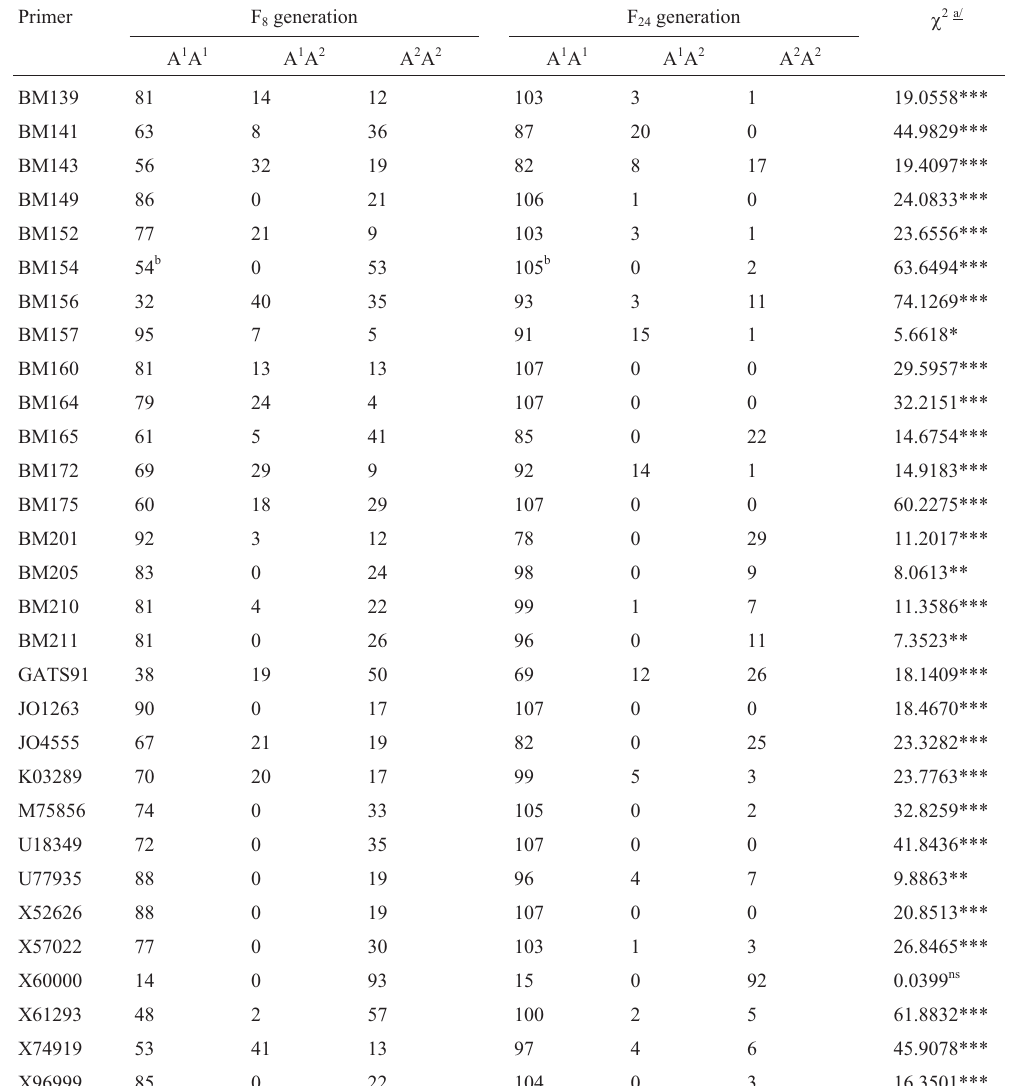
Figure 1 - Pattern of microsatellite bands amplified by the X74919 primer. From the left: first column Carioca MG; second column ESAL 686; the third column to the last column show the F 8:11 generation families 81 to 100. Table 1 - Number observed of the genotypes for the amplified microsatellite fragments in the F 8 and F 24 generations of a P. vulgaris cultivar Carioca MG and ESAL 686 cross and comparison of the two populations by the χ 2 test. The table shows the results for 30 microsatellite